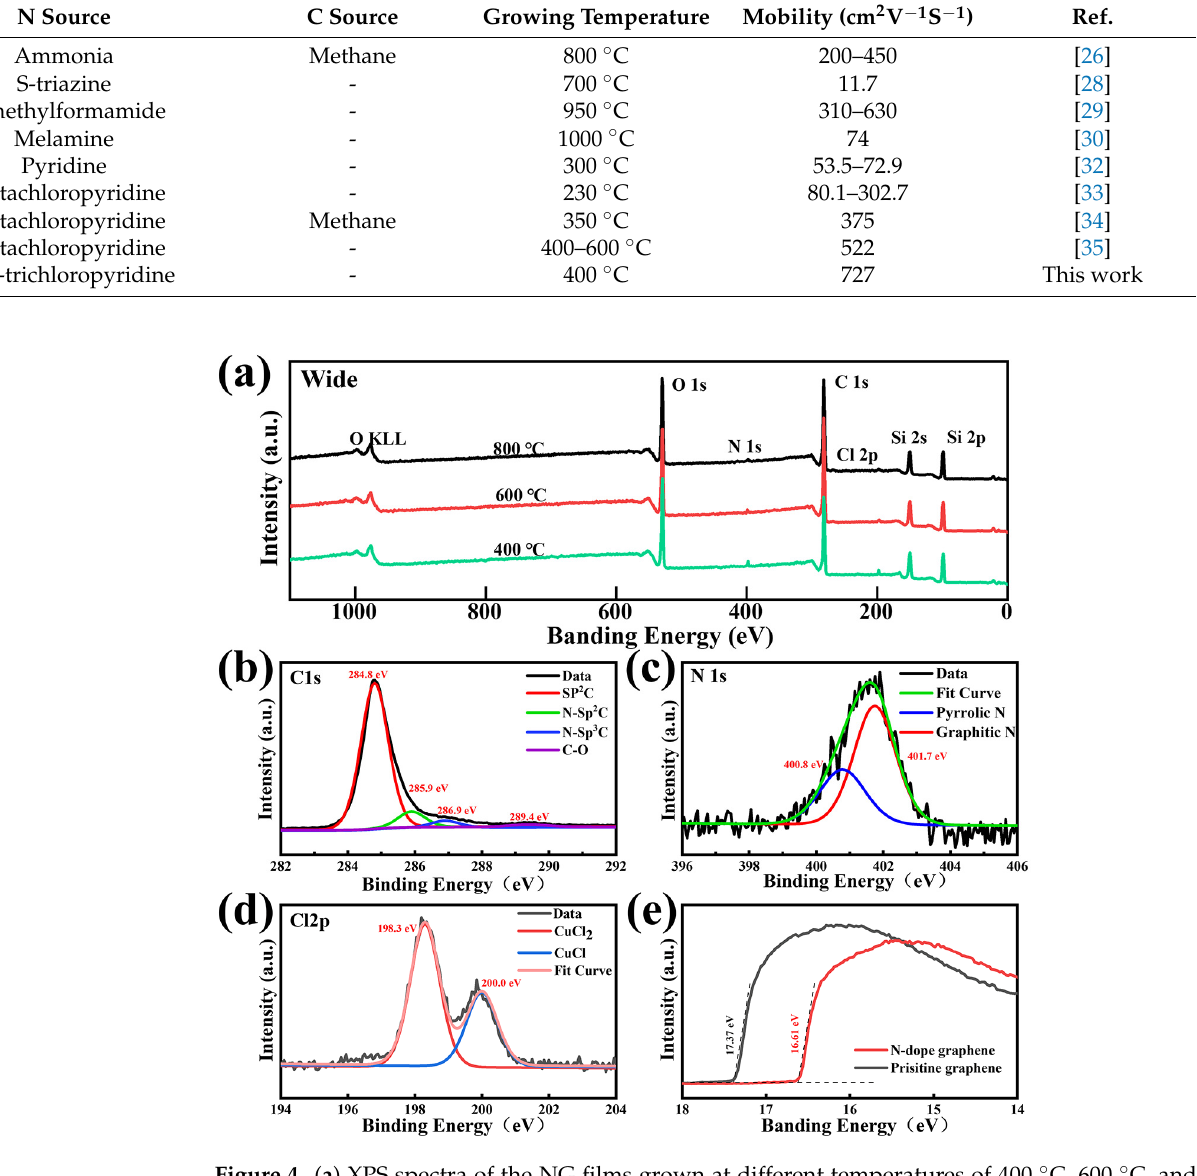
Figure 4. ( a ) XPS spectra of the NG films grown at different temperatures of 400 ◦ C, 600 ◦ C, and 800 ◦ C, respectively. High-resolution XPS spectra of ( b ) C 1s, ( c ) N 1s, and ( d ) Cl 2p peaks of the corresponding NG films. ( e ) The graph of the work function of pristine graphene and NG films.